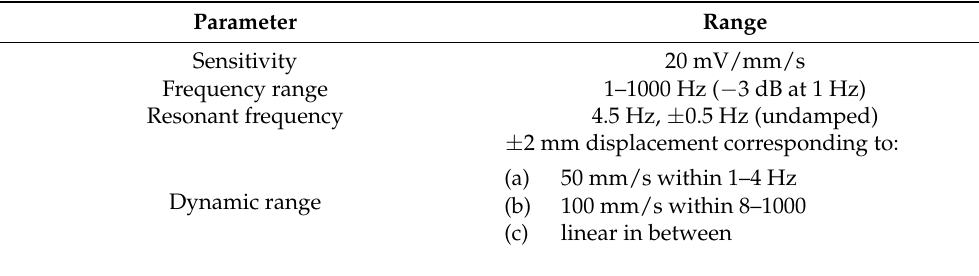
Figure 1. Cutaway view of a typical electret condenser microphone. Vibration velocity transducers used in the study (UVS Geophone DIN 4101 vertical, 4102 horizontal, 4103 triaxial) are electrodynamic transducers with resonant frequency compensation and provide a linear response characteristic from 1 Hz (Table 3). Table 3. Technical specification of